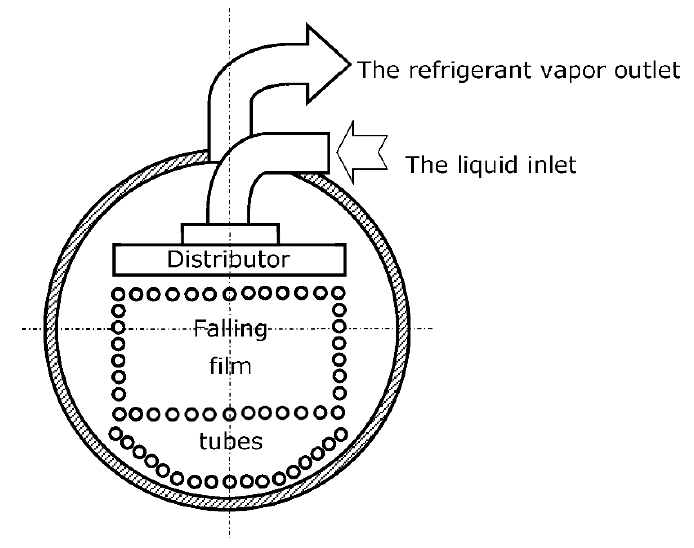
Figure 1. The schematic diagram of the large falling film evaporator.